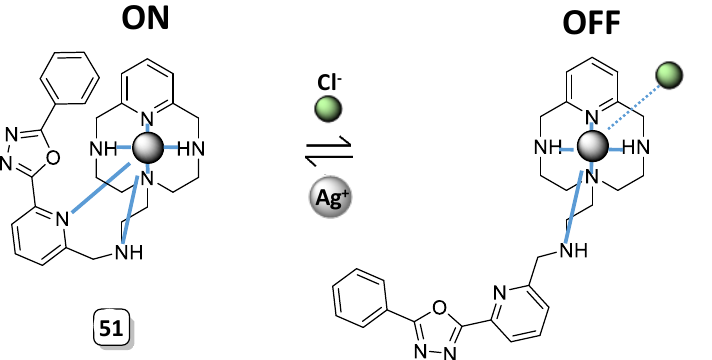
Figure 4. Intramolecular displacement of the dye by the Cl − anions. Adapted with permission from Ref. [70]. Copyright 2021, MDPI, Basel, Switzerland.